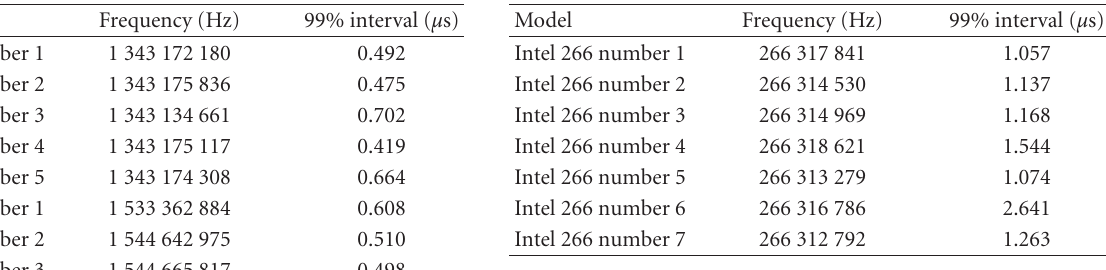
Table 3: Clock frequency for 5 1.3 and 3 1.5GHz AMD micropro- cessors.